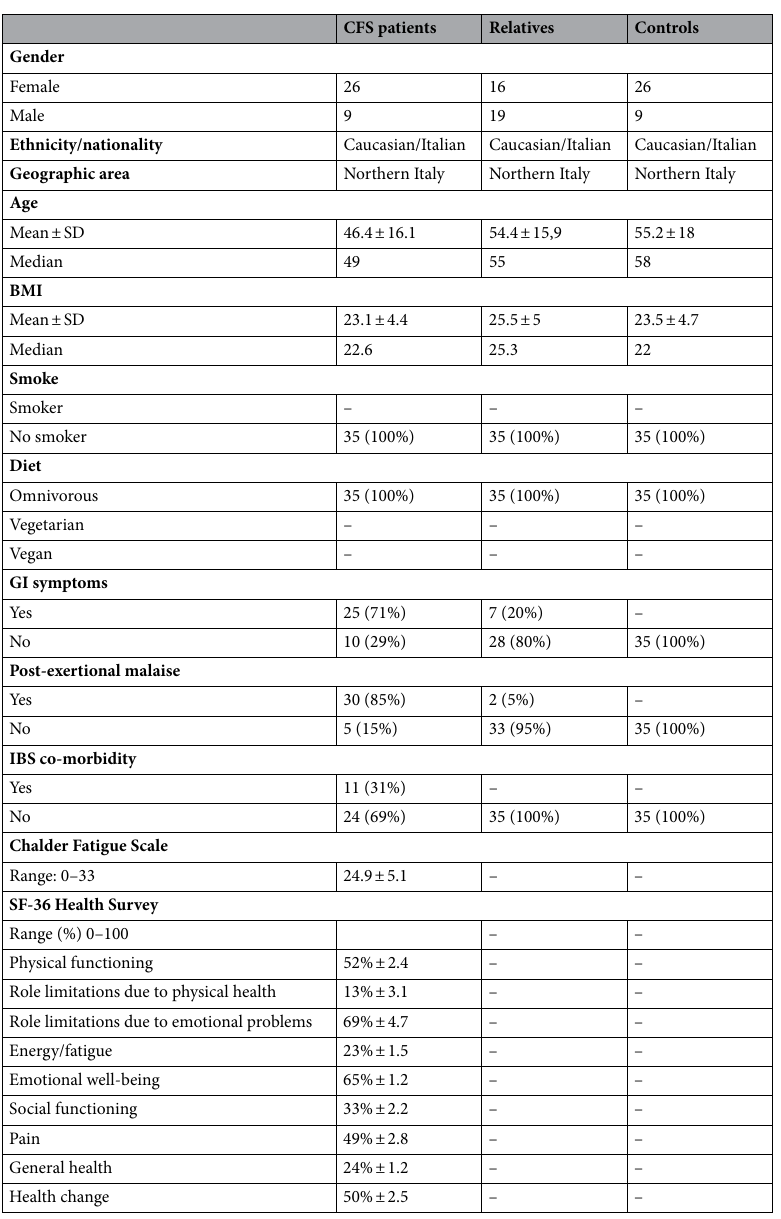
Table 1. Characteristics of study population. BMI Body mass index, GI gastrointestinal, IBS Irritable Bowel Syndrome.